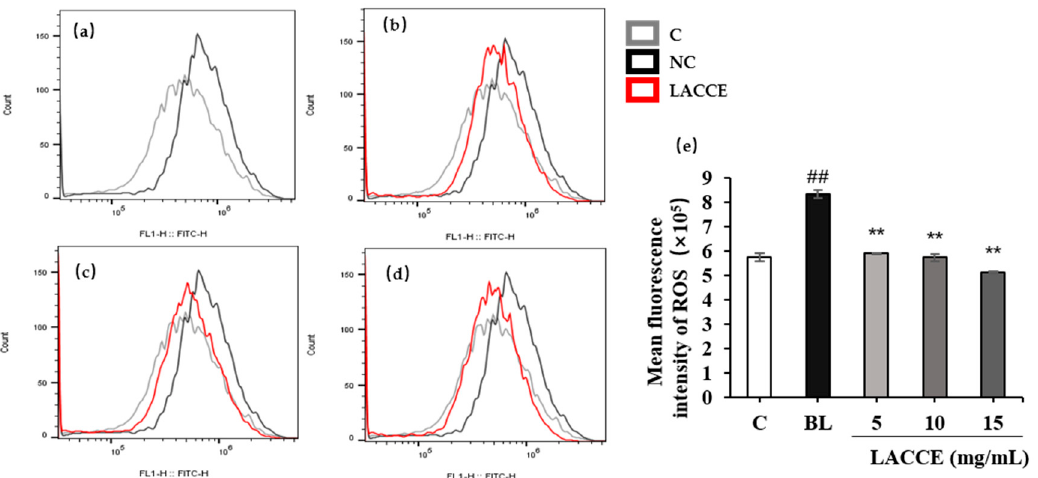
Figure 10. Effect of LACCE on ROS level. ( a ) Comparison of ROS levels between the blank control group (C) and blue light model group (BL). ( b ) Influence of 5 mg/mL LACCE on ROS levels. ( c ) Influence of 10 mg/mL LACCE on ROS levels. ( d ) Influence of 15 mg/mL LACCE on ROS levels. ( e ) Quantitative analysis of ROS fluorescence intensity ( n = 3). The data are expressed as mean ± standard deviation (SD) of three independent experiments. The data were analyzed using one-way analysis of variance (ANOVA) followed by Tukey’s test. ## p < 0.01 vs. C. ** p < 0.01 vs.